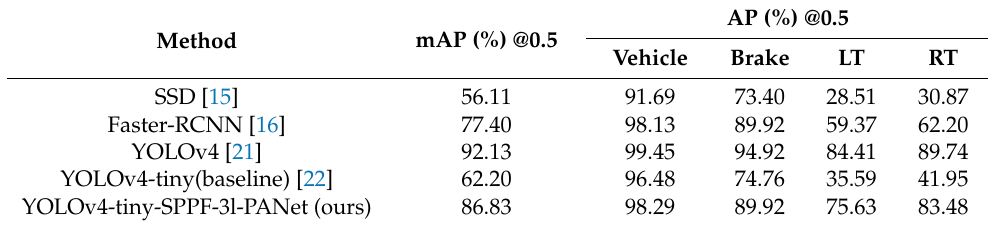
Table 5. Comparison experiment results for vehicle taillight